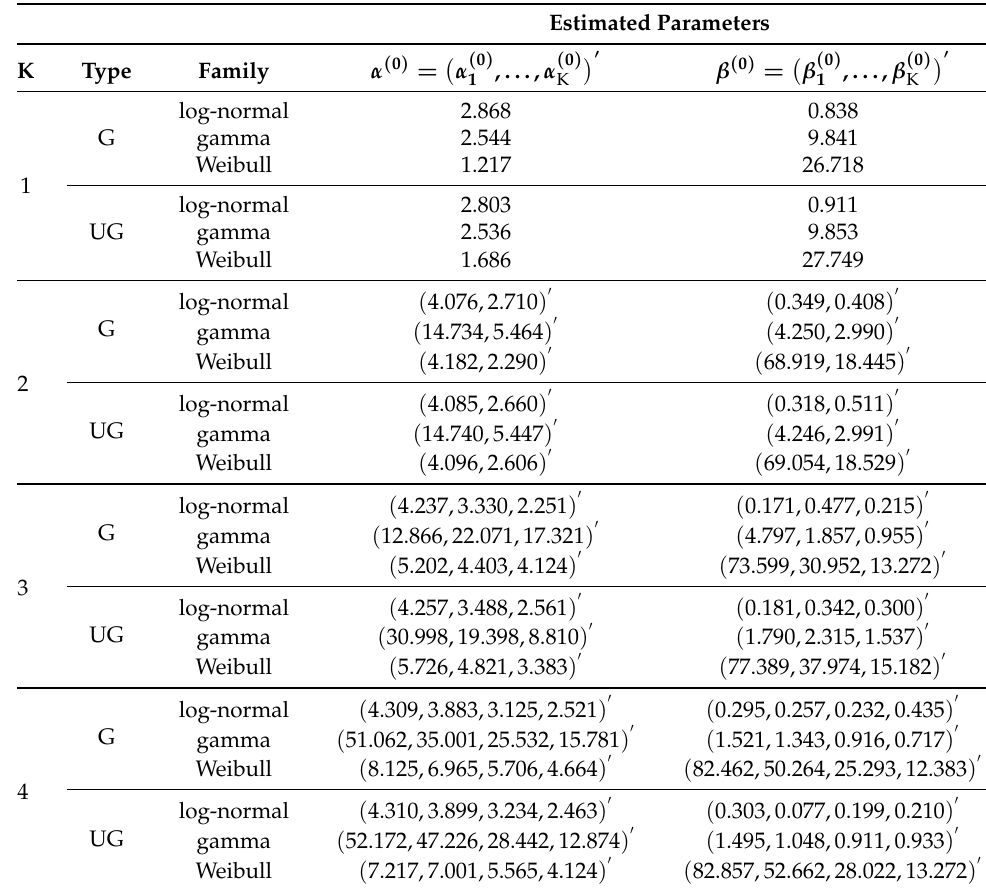
Table A3. Initial values of the EM algorithm for sample 3 obtained using the K-means clustering approach when DBH data are ungrouped (UG) and grouped (G) in classes of width 2.5 cm. It should be noted that the estimated vector of mixing parameters is not given for the sake of saving space.